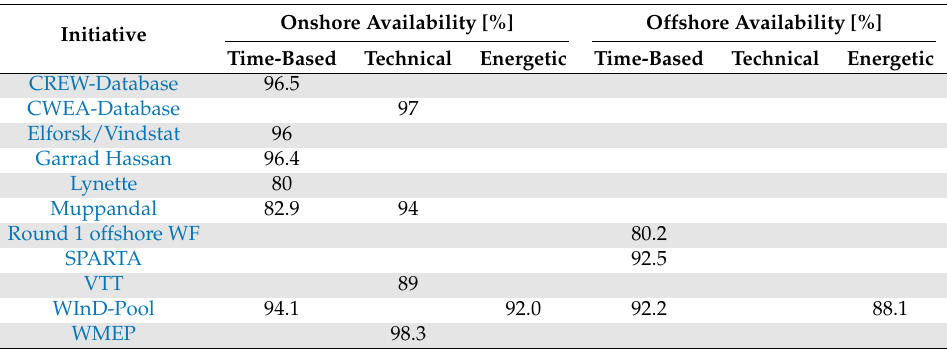
Table 3. Availability metrics of onshore and offshore WT as published by different initiatives. Initiative